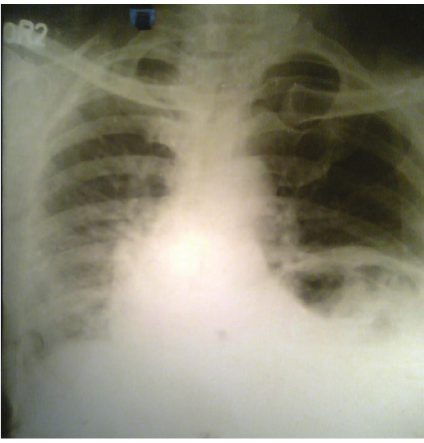
Figure 1: Chest X-ray PA view showing a heterogeneous opacity in the left lower zone.